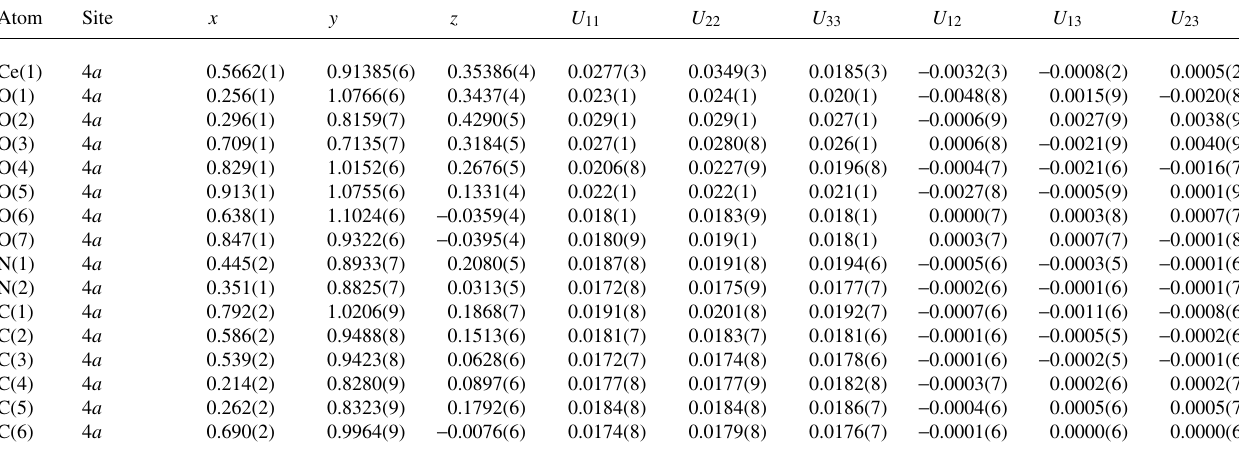
Table 3. Atomic coordinates and displacement parameters (in Å 2 ) .